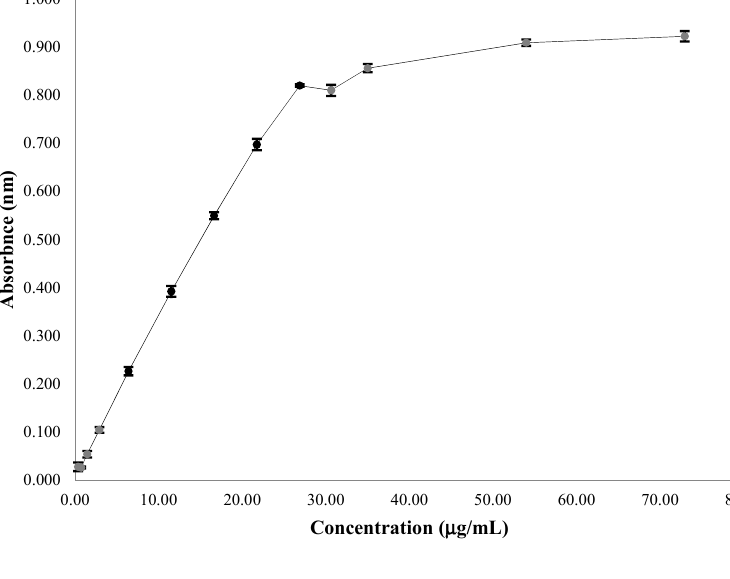
Figure 3. Absorbance versus concentration curve in the analysis of TP in CE from L. brasiliense ; linearity (6.40 to 26.88